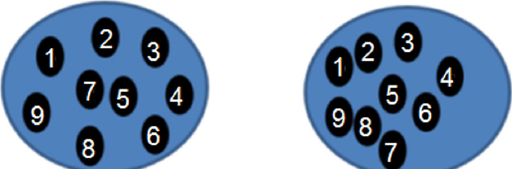
FIG. 3. Snapshots of a colloid system. Since snapshots are microstates of the system, and do not represent an ensemble, the two representations are equally